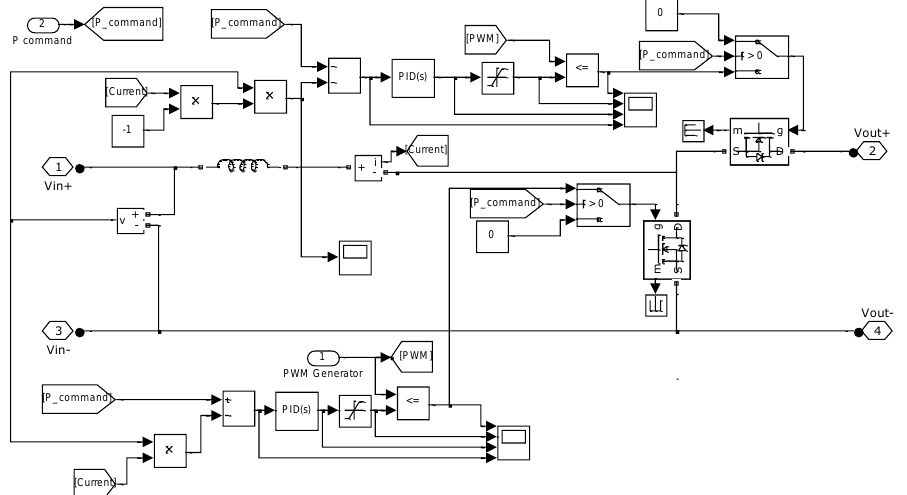
Figure 6. Model of bi-directional DC/DC converter.